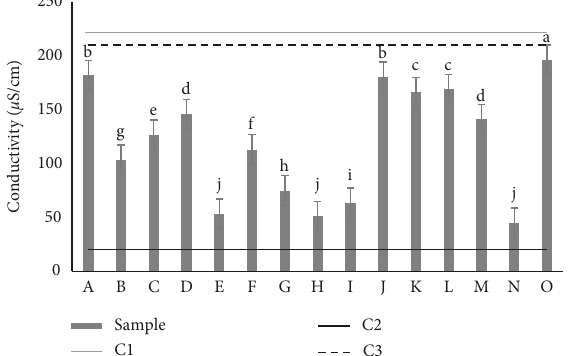
Figure 4: The ion conductivity values for 15 samples of treated water. A-B: Sg. Ramal ; C-E: Section 8, Bandar Baru Bangi ; F-I: Section 16, Bandar Baru Bangi ; J, K, and O Section 3, Bandar Baru Bangi ; L-N: Section 15, Bandar Baru Bangi . C1: household mineral water (Cuckoo); C2: distilled water; C3: commercial mineral water